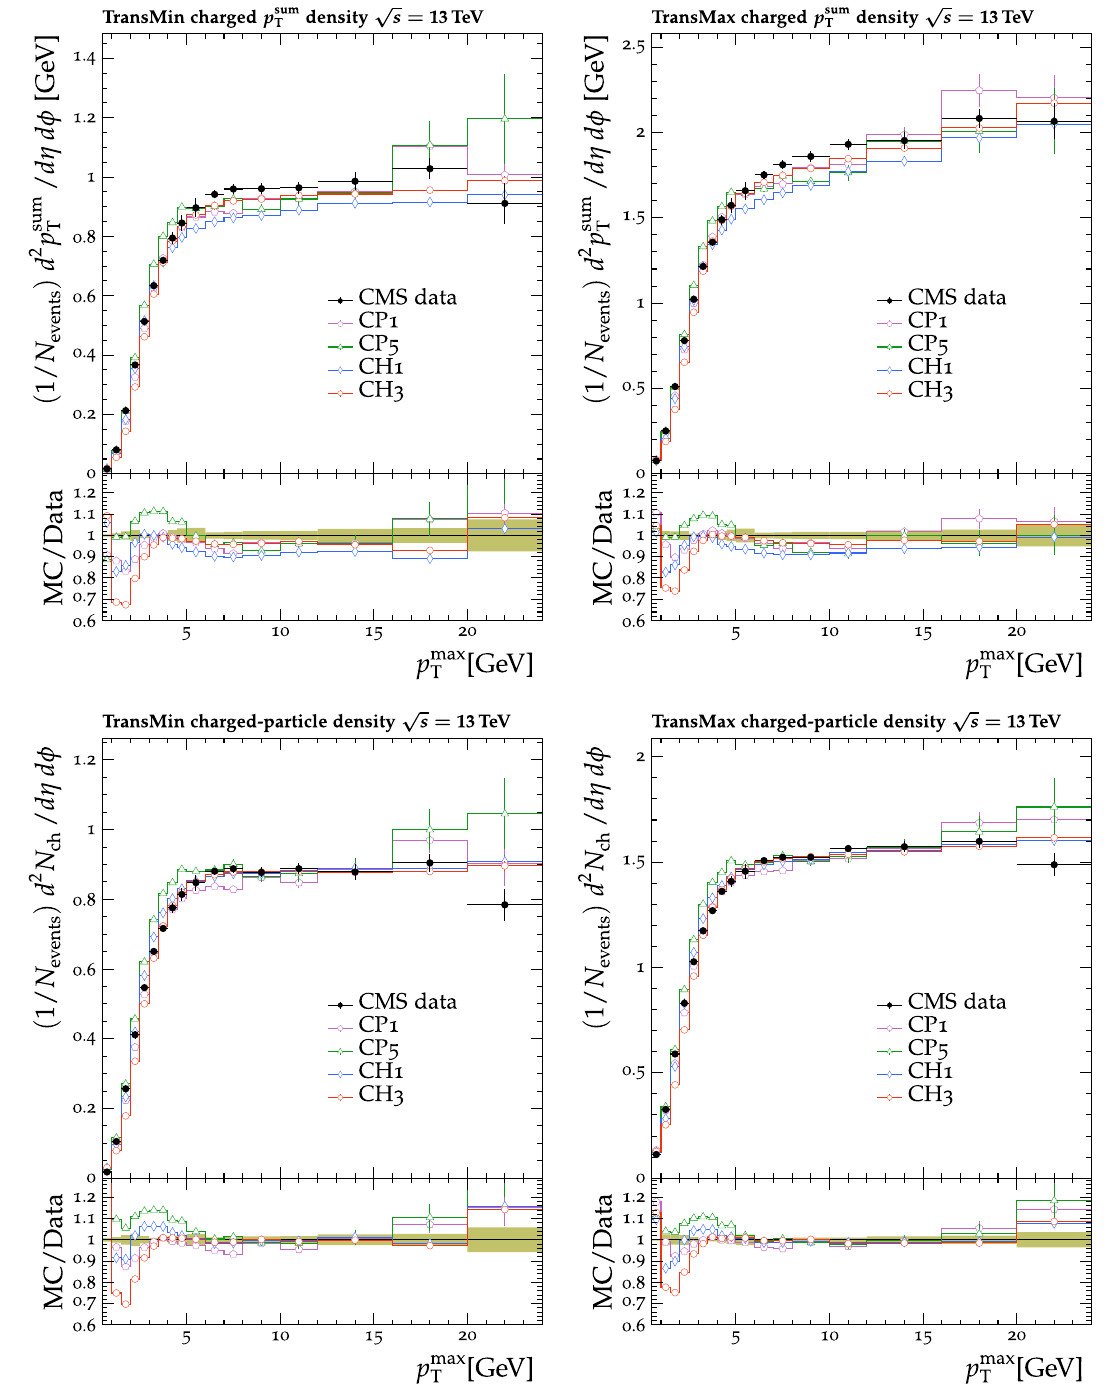
pythia 8, with the CP1 and CP5 tunes. The coloured band in the ratio Fig. 7 The p sum (upper) and N ch (lower) density distributions in the T transMin (left) and transMax (right) regions, as a function of the p T plot represents the total experimental uncertainty in the data. The verti- of the leading track, p max [24]. CMS MB data are compared with the calbarsonthepointsforthedifferentpredictionsrepresentthestatistical T predictions from herwig 7, with the CH1 and CH3 tunes, and from uncertainties tuned parameters for each tune can be distinguished. For increases the amount of MPI in an event compared to that is lower for all three CH tunes example, the value of p min ⊥ , with the tune 0 than for SoftTune, and significantly lower for CH1 , which